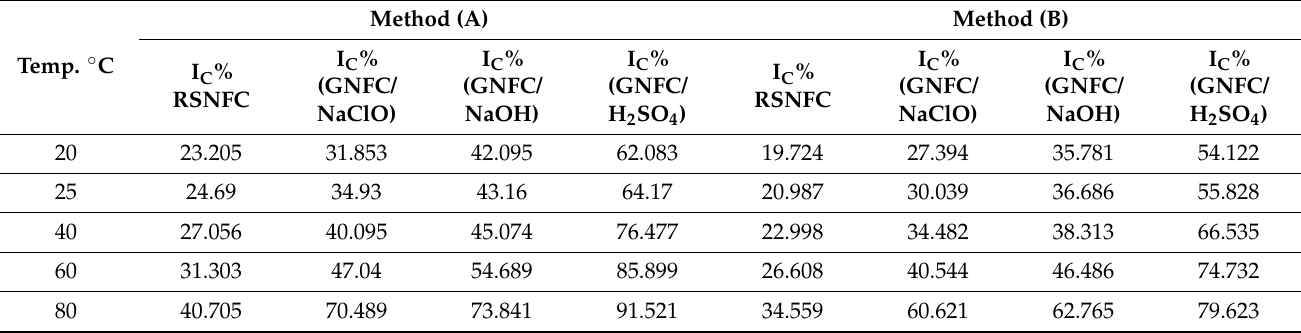
Table 1. Variation of I c for RSCNFC (Real Sample Commercial Nanofiber Cellulose), GNFC/NaClO, GNFC/NaOH, and GNFC/H 2 SO 4 with test temperature using both method A and method B.